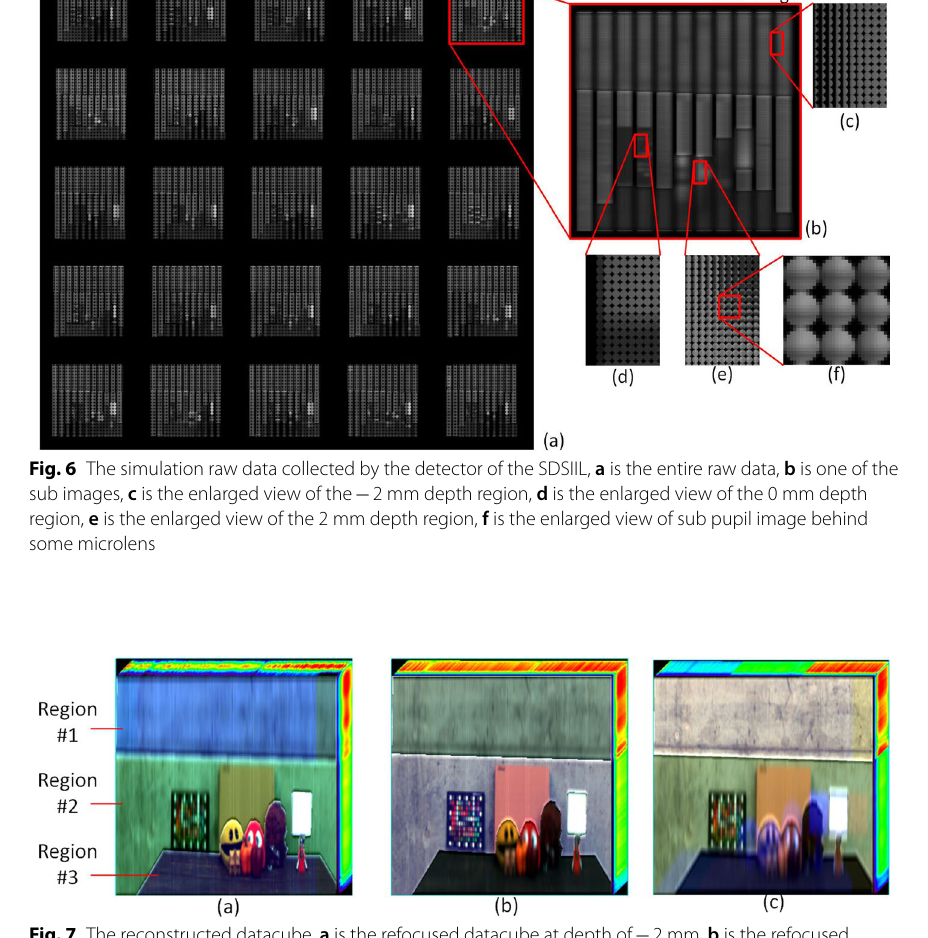
2 mm, b is the refocused −